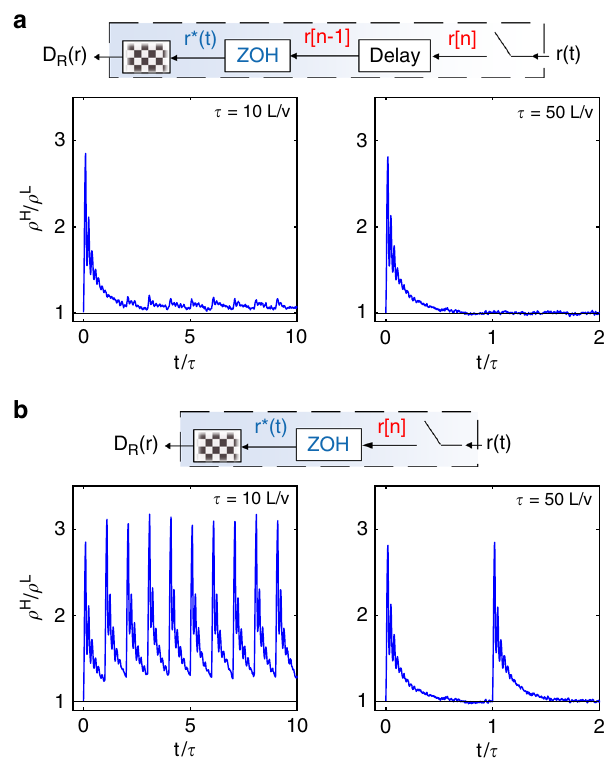
Fig. 6 Oscillating localization for τ > L / v with and without delay in the feedback loop. a Simulated time evolution of ρ H / ρ L , directly calculated from the density distribution ρ ( x , y ) at each time step. D R is updated every t = n τ based on the past particle ’ s position r ( t − τ ). b Same as in a except for that D R is updated every t = n τ based on the current position r ( t = n τ ). The simulation parameters are v = 3.5 μ m s − 1 , L = 32 μ m, D H D L = 0.01 rad 2 s − 1 R